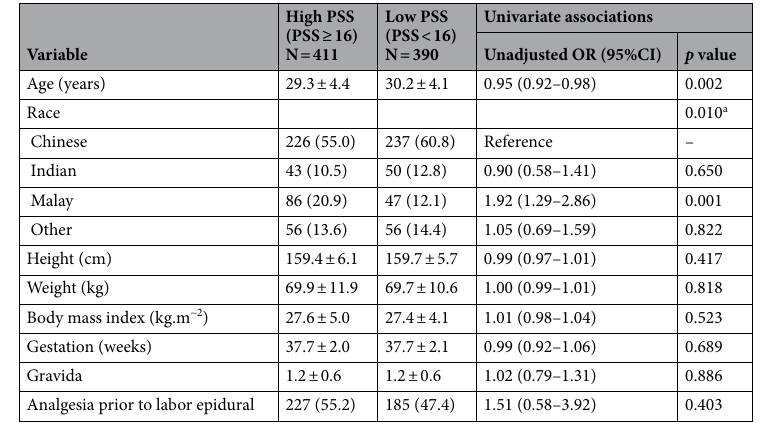
Table 1. Univariate associations of baseline parturient and clinical characteristics with perceived stress levels during labor. Data presented as n (%) or mean ± SD for categorical and continuous data respectively. a Type 3 or omnibus -value.